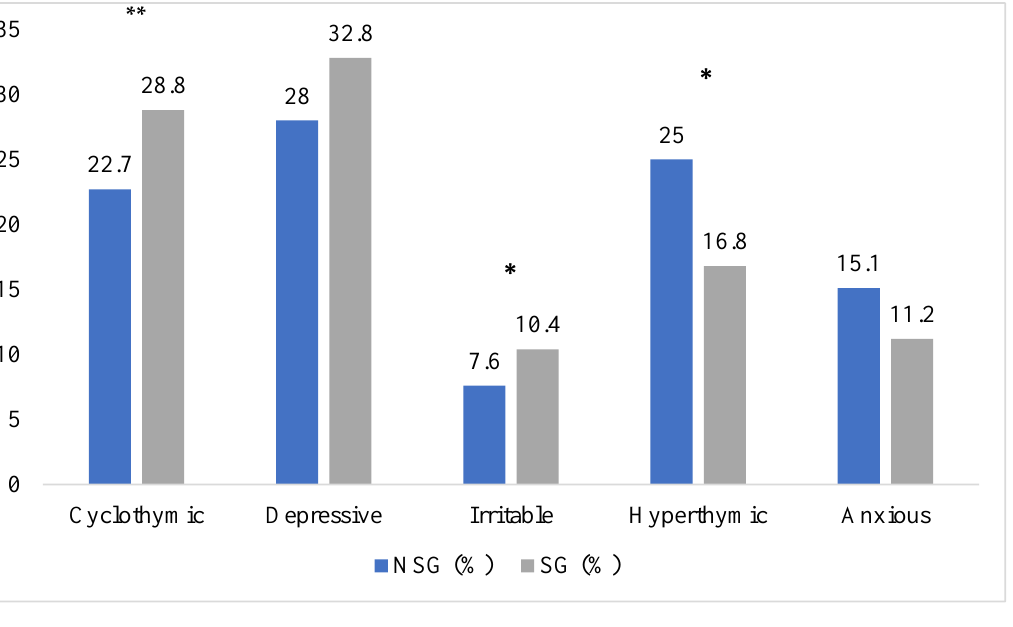
Figure 1. Distribution of suicide attempts lifetime among affective temperaments. * p < 0.01; ** p < 0.001; NSG: non suicidal group; SG: suicidal group.